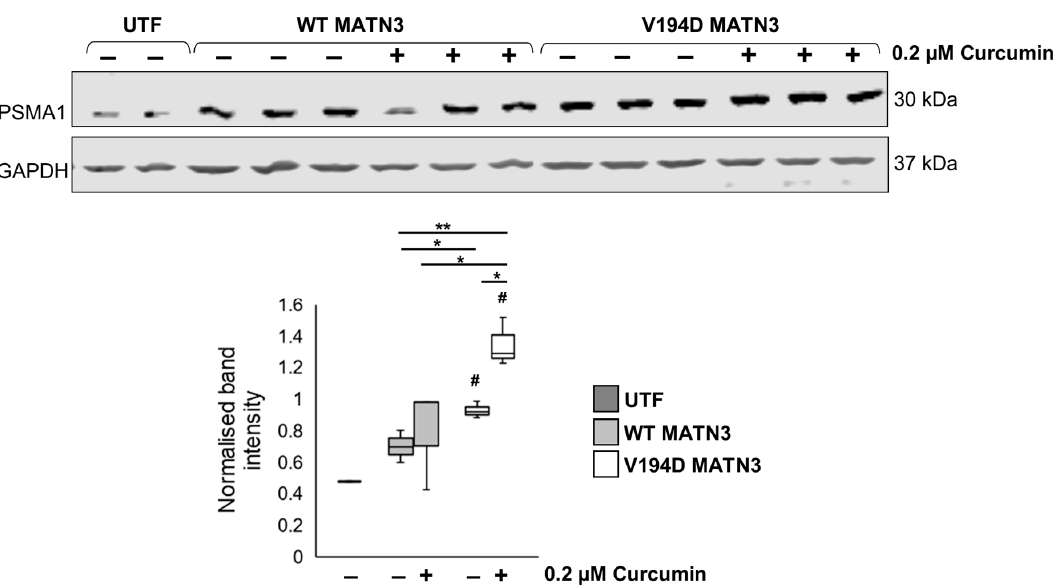
Figure 6. Curcumin treatment upregulates proteasome expression in mutant matrilin-3-expressing cells. WT and V194D mutant MATN3-expressing HELA cells were cultured in the presence/absence of 0.2 µ M curcumin for 48 h and the intracellular expression of the proteasomal subunit PSMA1 was analysed by Western blotting. PSMA1 levels are unaffected by curcumin treatment in WT MATN3 cells; however, administration of curcumin promotes the upregulation of PSMA1 in V194D MATN3 cells. (Equal loading shown by GAPDH. PSMA1: proteasomal subunit alpha-type 1, GAPDH: glyceraldehyde-3-phosphate dehydrogenase, MATN3: matrilin-3, WT: wild-type, UTF: untransfected, # significant to UTF, * p <0.05, ** p < 0.005, n = 3). To confirm if mutant matrilin-3 is degraded by the proteasome following the admin- istration of curcumin, a proteasome inhibitor, PSII, is added to block the effects of curcu- min. As observed in Figure 3, curcumin treatment significantly reduces the intracellular